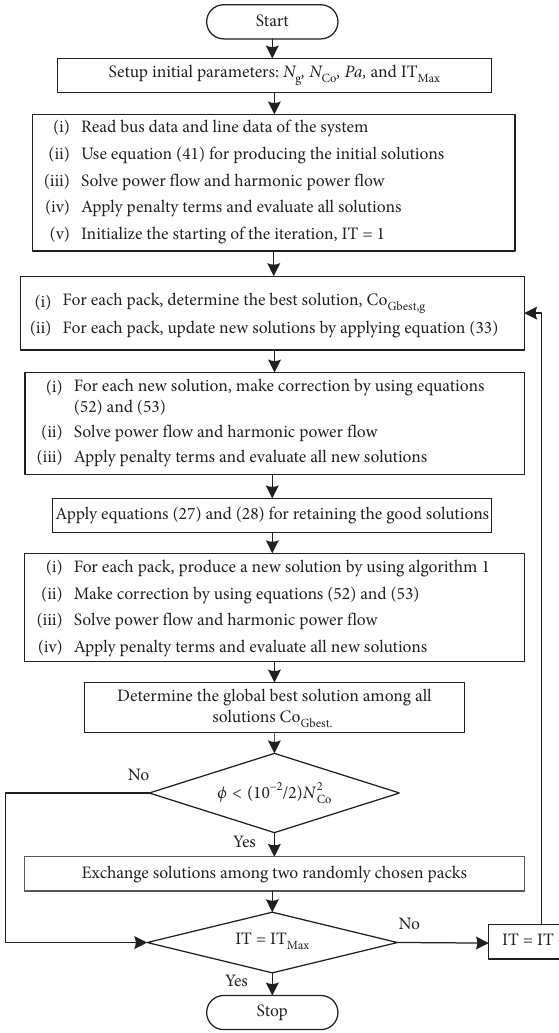
Figure 1: Flowchart of the computation